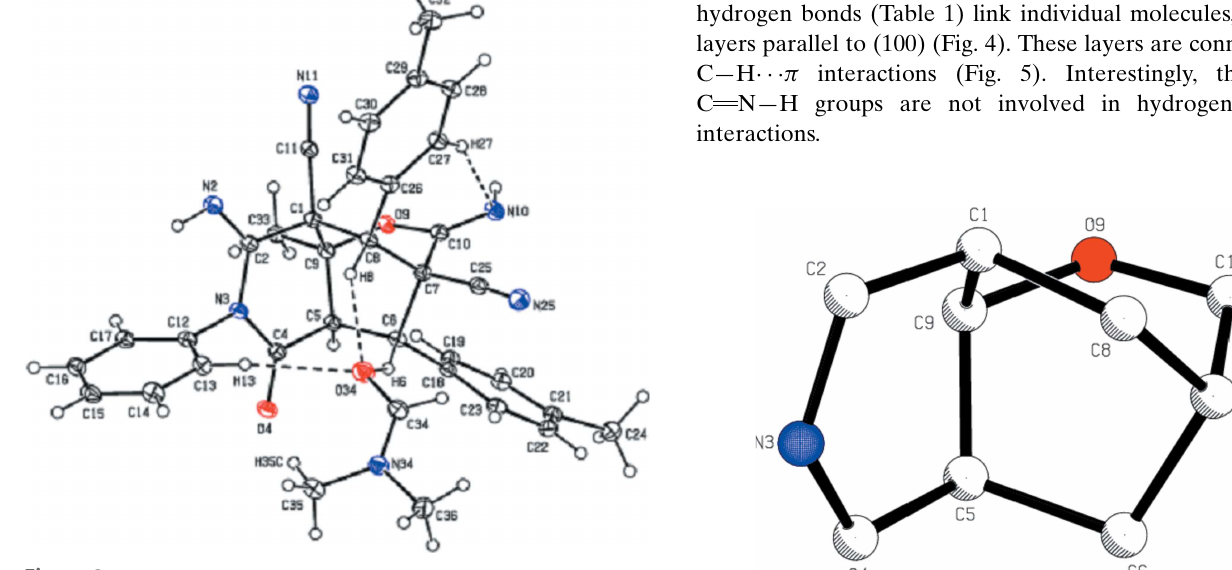
Figure 3 View of the octahydro-2 H -3,8-methanopyrano[3,2- c ]pyridine ring sytem of the title